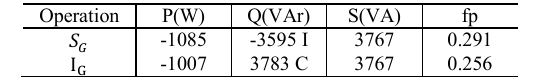
Table II. Active, Reactive and Total Power and Power Factor in 𝑆 𝐺 e 𝐼 𝐺 for 𝑁 𝐿 .